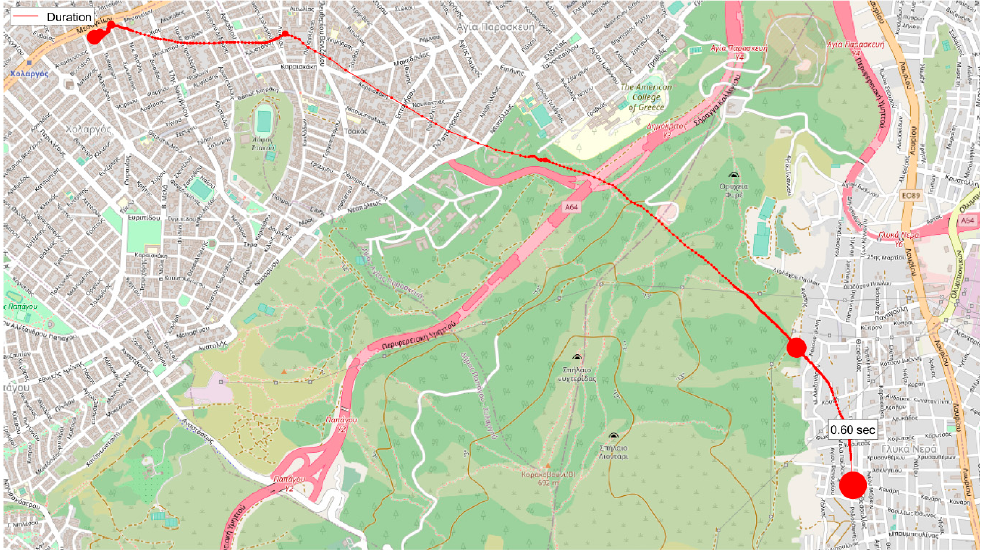
Figure 6. Duration diagram. Durations are depicted as circles where larger circle radii correspond to higher durations and vice